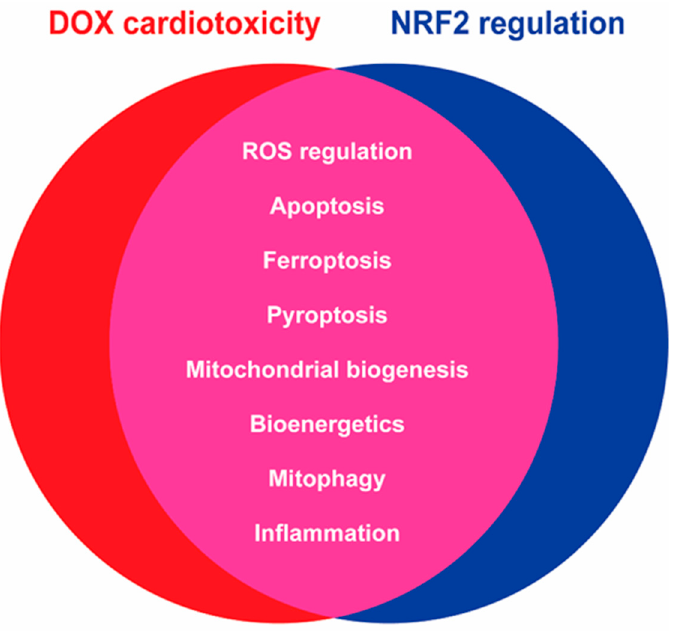
Figure 4. Interplay between mechanisms through which doxorubicin (DOX) induces deleterious off-target cardiotoxic events and pathways regulated under NRF2 transcriptional control.